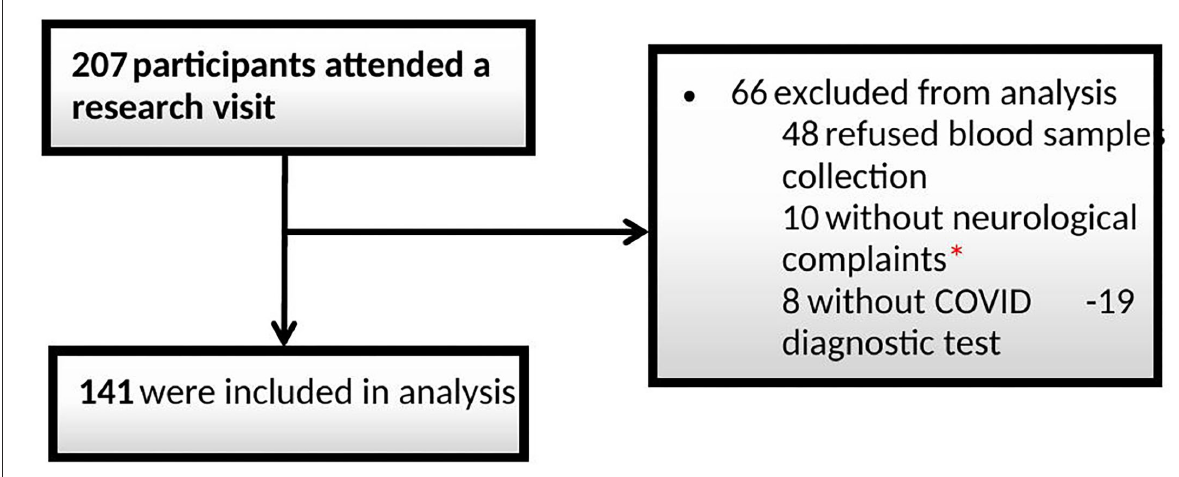
FIGURE1 Flow diagram of participants. *E.g., headache, anosmia, cognitive complaints and others.